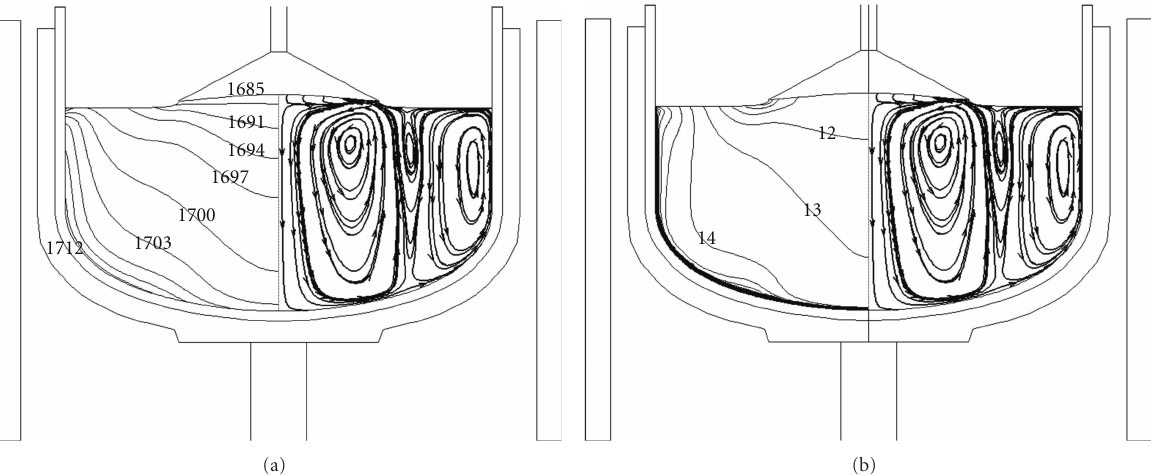
Figure 3: Distribution of the temperature, streamtrace, and oxygen concentration in the melt for L = 50 mm in a conventional CZ furnace ( h = 0mm): (a) isothermal lines (left) and streamtraces (right); (b) oxygen concentration isolines (left) and streamtraces (right). The units of temperature, velocity vector, and oxygen concentration are K, m/s, and ppma, respectively. The spacing of the isothermal lines and concentration isolines are 3 K and 1ppma, respectively.